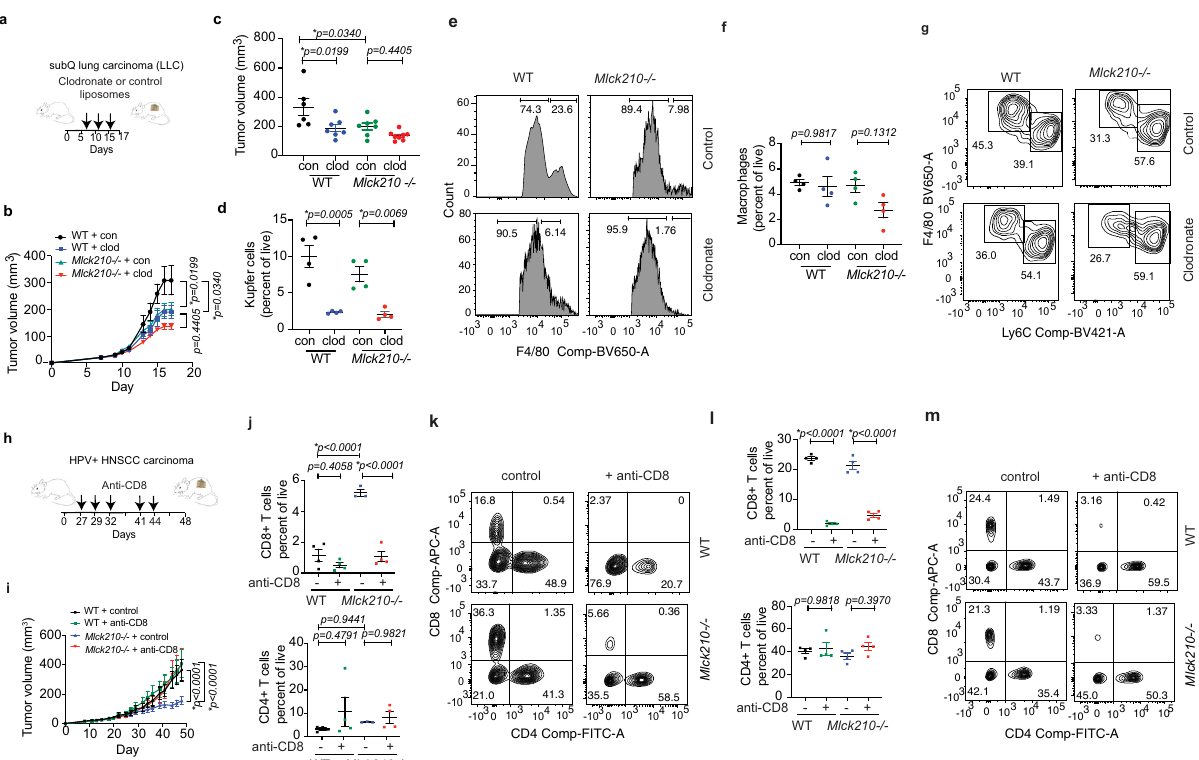
Fig. 8 CD8 + T cells facilitate Mlck210 − / − -mediated tumor suppression. a Schematic of clodronate and control liposome treatment of LLC tumor bearing mice. b, c LLC tumor volumes over time ( b ) and endpoint tumor volumes ( c ) for WT ( n = 6 mice treated with control liposomes (con) and 8 mice treated with clodronate liposomes (clod) and for Mlck210 − / − [ n = 7 mice treated with control liposomes (con) and clodronate liposomes (clod)]. One WT animal treated with clodronate liposomes died on day 14 post-tumor inoculation and was not included in the fi nal tumor weight graph. d – g Quanti fi cation ( d , f ) and FACs plots of Ly6C- ( e ) liver and ( g ) tumor macrophages from WT and Mlck210 − / − mice after treatment with clodronate and control liposomes ( n = 4 mice). For Facs gating scheme, see Supplementary Fig. 7a. h Schematic depicting anti-CD8 and control antibody treatment of HPV + Meer WT and Mlck210 − / − tumor bearing mice. i Time course of tumor growth for control and anti-CD8 antibody-treated WT and Mlck210 − / − mice ( n = 12 WT and n = 8 Mlck210 − / − control mice, and n = 11 WT and n = 8 Mlck210 − / − anti-CD8-treated mice). Statistical signi fi cance determined by linear regression analysis. j , k Quanti fi cation ( j ) and FACs plots ( k ) of tumor associated CD8 + and CD4 + T cells in mice from i ( n = 4 mice). For Facs gating schemes, see Supplementary Fig. 7c. l , m Quanti fi cation ( n = 4 mice) and FACs plots ( m ) of splenic CD8 + and CD4 + T cells in mice from i . For Facs gating schemes, see Supplementary Fig. 7c. Statistical signi fi cance determined by one-way Anova with Tukey ’ s posthoc testing. Data are presented as mean values ± SEM. Experiments were performed twice. Source data are provided with this article as a Source Data fi